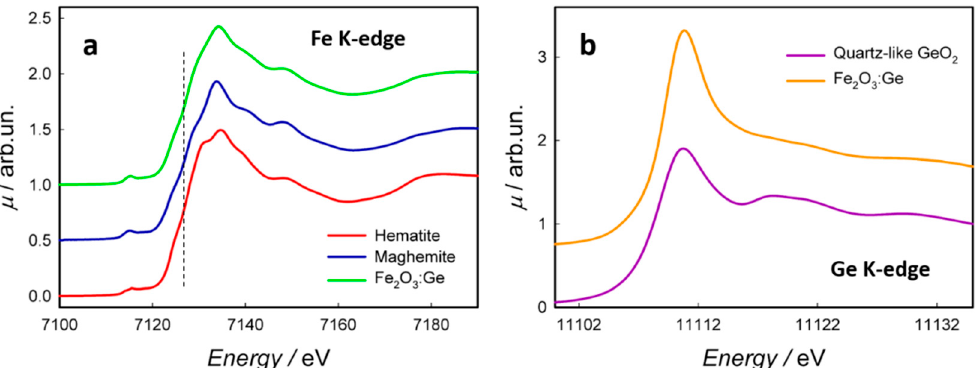
Figure 4. ( a ) XANES spectra at the Fe K-edge of Fe 2 O 3 :Ge NFs, hematite and maghemite (these last spectra taken from ref [85]. The spectra are shifted along the y -axis for better comparison. The absorption edge energy, common to all the three spectra, is indicated as a black dotted line. ( b ) XANES spectra at the Ge K-edge of Fe 2 O 3 :Ge NFs and of quartz-like GeO 2 . The spectra are shifted along the y -axis for better comparison.